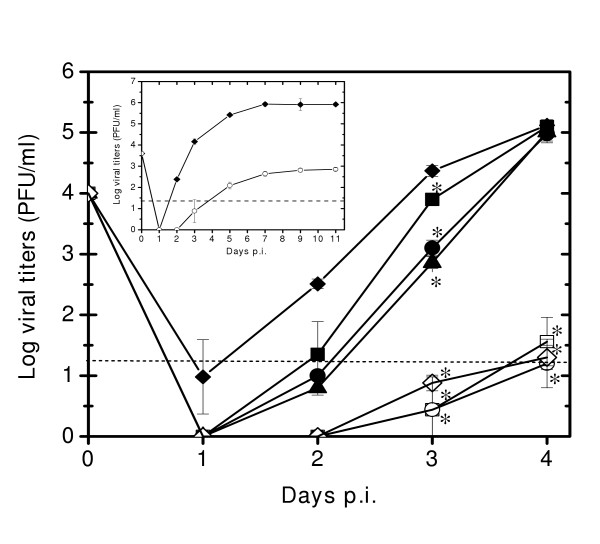
IFN-α, IFN-β and/or IFN-γ inhibit HCMV replication in HFFs. HFFs were treated with vehicle or 100 IU/ml of IFNs 12 h prior to infection with HCMV at a MOI of 2.5: (◆) vehicle, (■) IFN-α, (●) IFN-β, (▲) IFN-γ, (□) IFN-α and IFN-γ, (○) IFN-β and IFN-γ or (◇) GCV (100 μM). On the indicated d p.i., average viral titers (n = 3) were determined by a microtiter plaque assay. HFFs were inoculated for 2 h with serially diluted lysed cultures. Plaque numbers were determined 11 d p.i. by fluorescence microscopy. At 3 d p.i., all IFN treatments significantly reduced viral titers as compared to vehicle-treated cultures (P < 0.001, one-way ANOVA and Tukey's post hoc t test). At 4 d p.i., only cells treated with GCV or combination IFN treatments inhibited viral titers as compared to vehicle-treated HFFs (P < 0.001, one-way ANOVA and Tukey's post hoc t test). Significant reduction denoted by a single asterisk. Inset: Represents HCMV titers determined over 11 d for (◆) vehicle-treated and (○) IFN-β and IFN-γ-treated HFFs. The dashed line represents the lower limit of detection of the plaque assay (20 PFU/ml) used to measure viral titers.